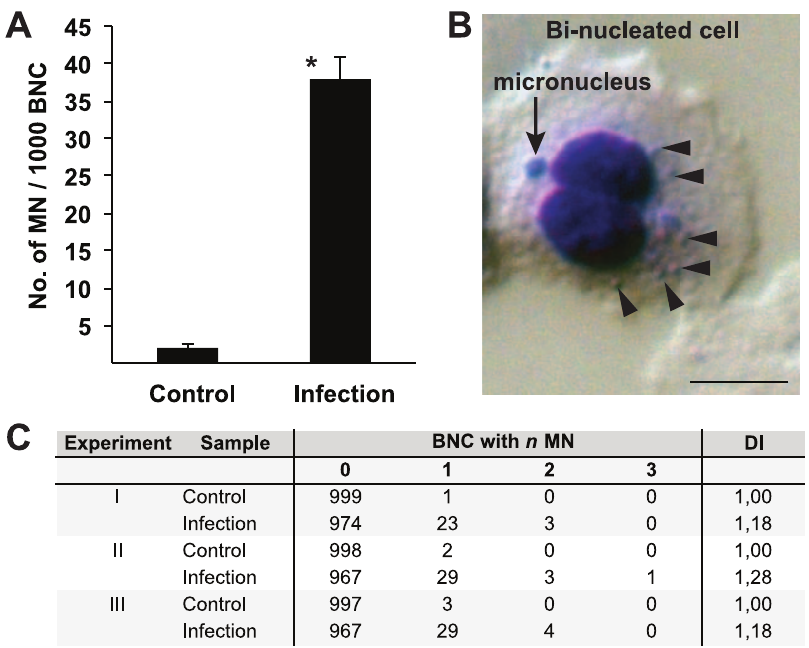
Figure 6. Bacterial infection induces micronuclei formation in VK2/E6E7 cells. VK2/E6E7 cells were infected with N. gonorrhoeae for 24 h. Cytokinesis was blocked with cytochalasin B for 36 h and BNC from infected and control cells were analyzed for micronuclei formation. A. Average numbers of observed micronuclei/1000 BNC ¡ standard deviation from 3 independent experiments are shown (* p , 0.05). B. DIC image showing a representative Giemsa-stained BNC (blue), containing one micronucleus (arrow) and several intracellular bacteria (arrowheads), captured using a 63 6 objective. Scale bar represents 10 m m. C. Frequencies of micronuclei formation and DI observed in 3 independent experiments where 1000 BNC were scored in each experiment are shown.